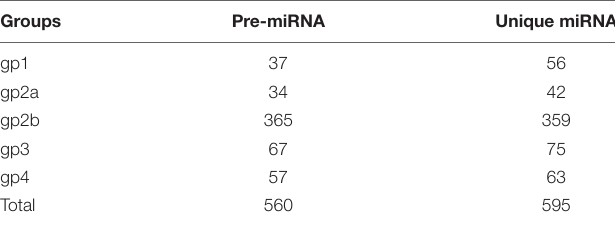
TABLE 5 | Summary of identified conserved and novel miRNAs.